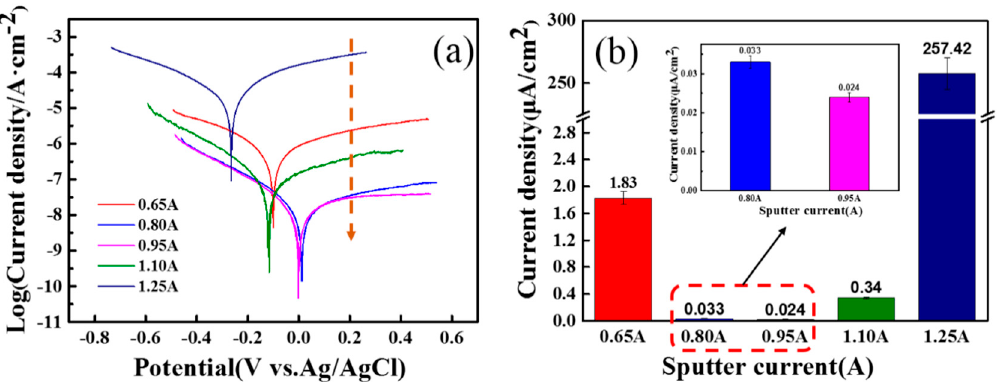
Figure 2. ( a ) Potentiodynamic polarization of TiC x O y films deposited at different sputter current in 3.5% NaCl solution; ( b ) Corrosion current density of TiC x O y films deposited at different sputter current at 0.2 V (vs. Ag/AgCl).